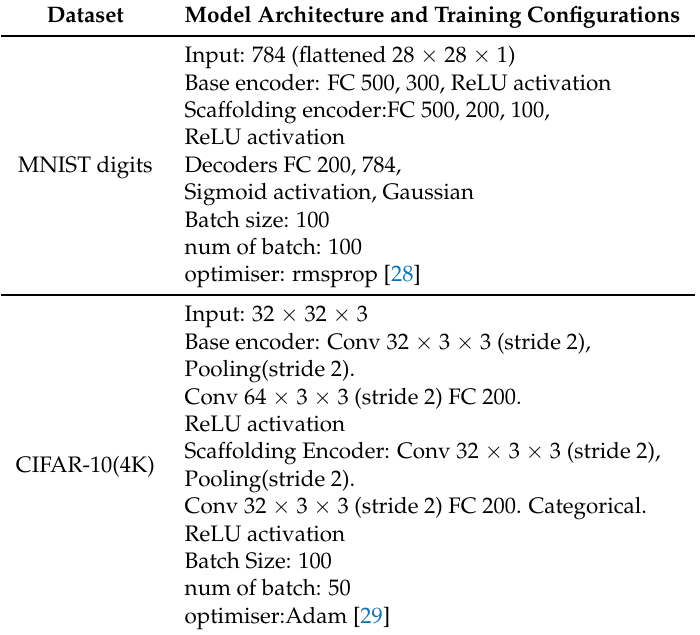
Table 1. Training configurations on the MNIST and CIFAR-10(4K)